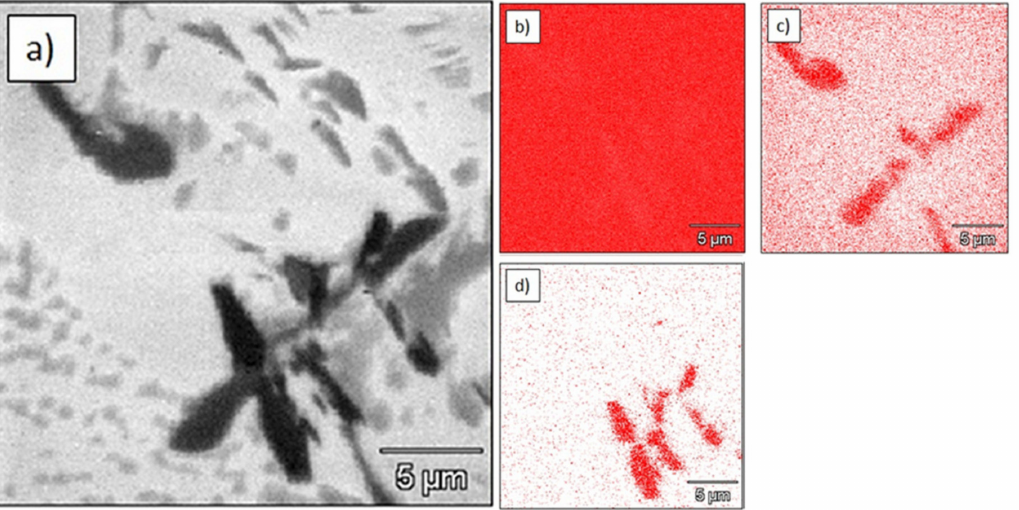
Figure 9. Microstructure and elemental maps of Ti-2.0%TiC sinter: ( a ) microstructure; ( b ) elemental map of titanium (EDS); ( c ) elemental map of carbon (WDS); ( d ) elemental map of boron